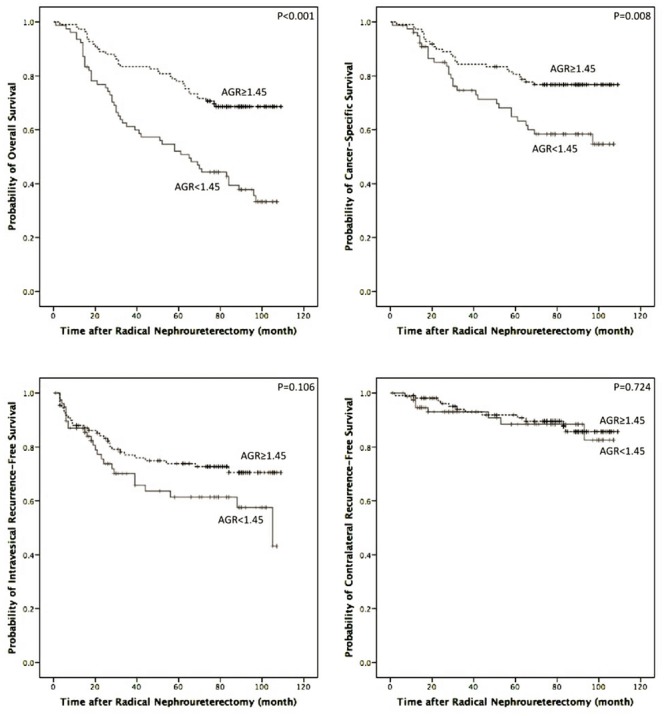
OS, CSS, IRFS and CRFS curve of patients with UTUC after radical nephroureterectomy (AGR≥1.45 vs. <1.45).